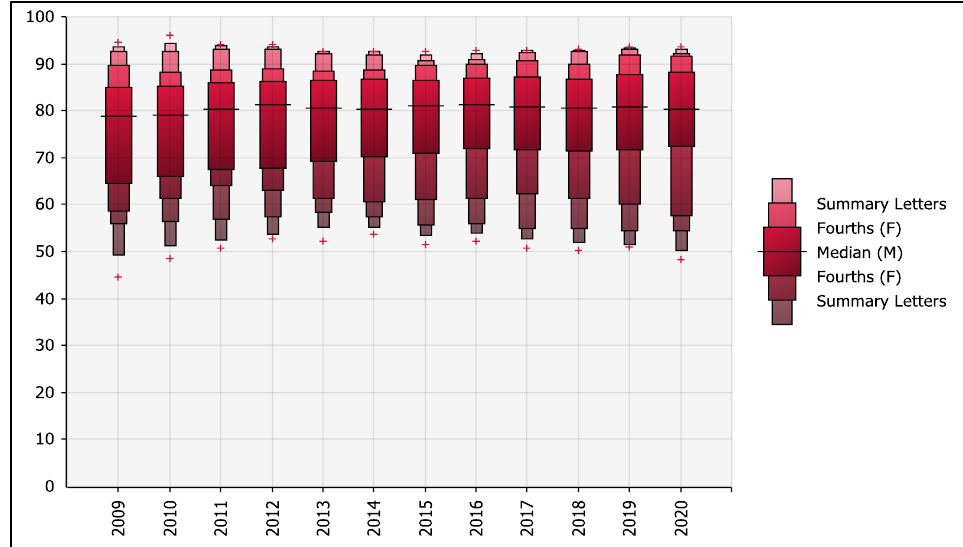
Figure 4. Letter value plot for the share of energy tax revenues in the environmental tax revenues of the EU27 in 2009 – 2020 (source: own study).